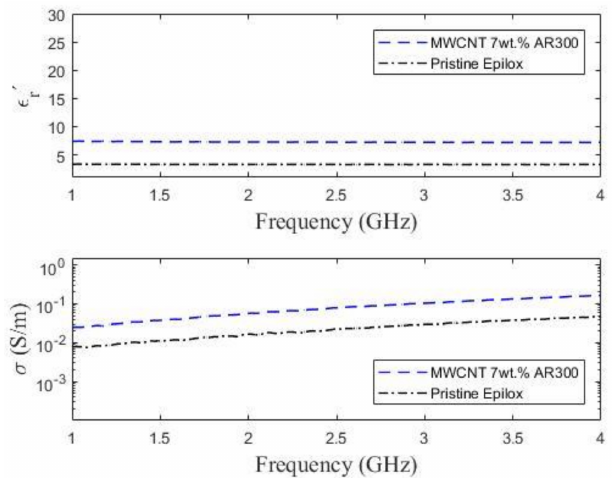
Figure 9. Dielectric constant and conductivity of a composite (i.e., Epilox matrix) containing 7 wt% of “low aspect ratio” (AR ≈ 300), high purity (98.5 wt%) MWCNTs.